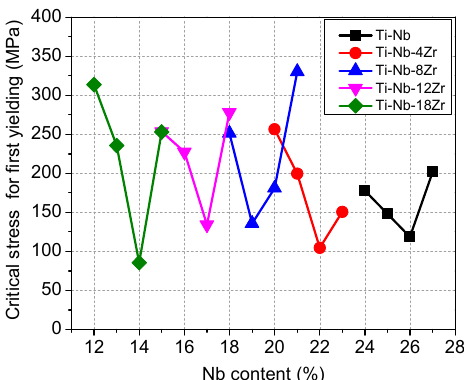
Figure 5. Nb content dependence of the critical stress for the first yielding for Ti–Nb and Ti–Nb–Zr alloys with various Zr content.